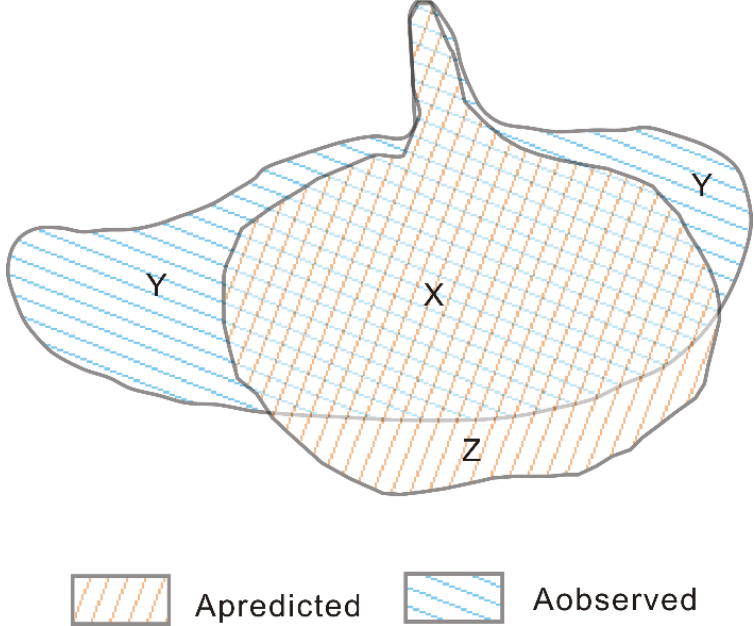
Figure 8. Schematic diagram of verification results of debris flow events. A predicted area was measured, and the observed area was from the simulation result. X is the positive accuracy area, Y represents the missing accuracy area, Z is negative.